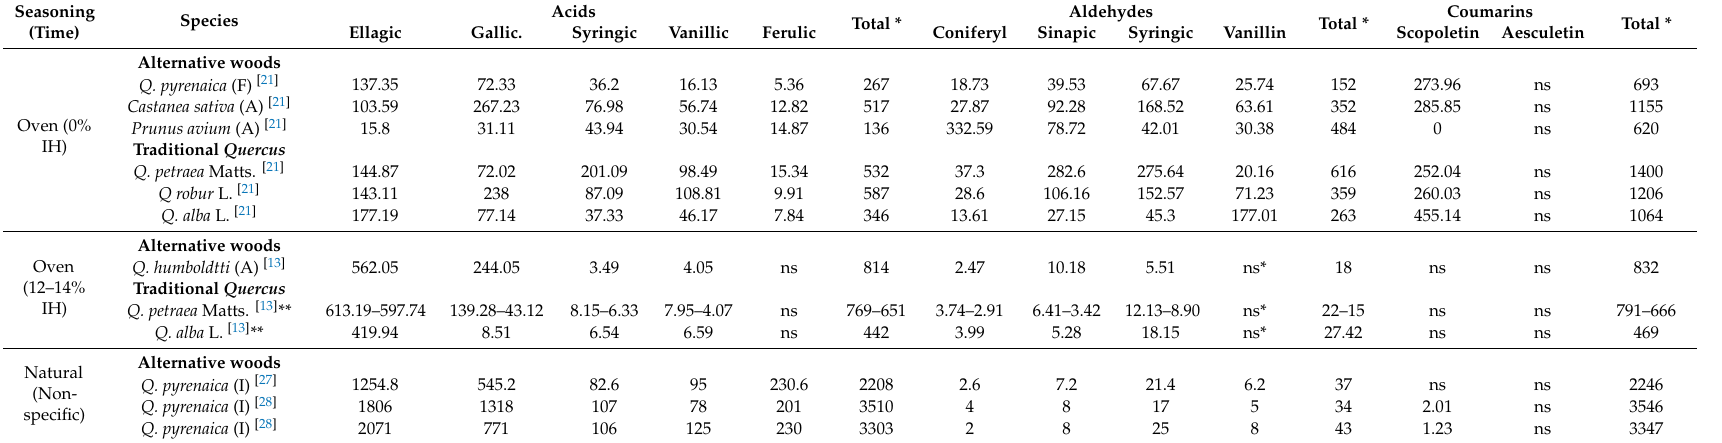
Table 6. Mean of the concentration expressed as µ g / g of the low molecular weight phenolic compounds found in seasoned woods of di ff erent botanical origin. Seasoning (Time)